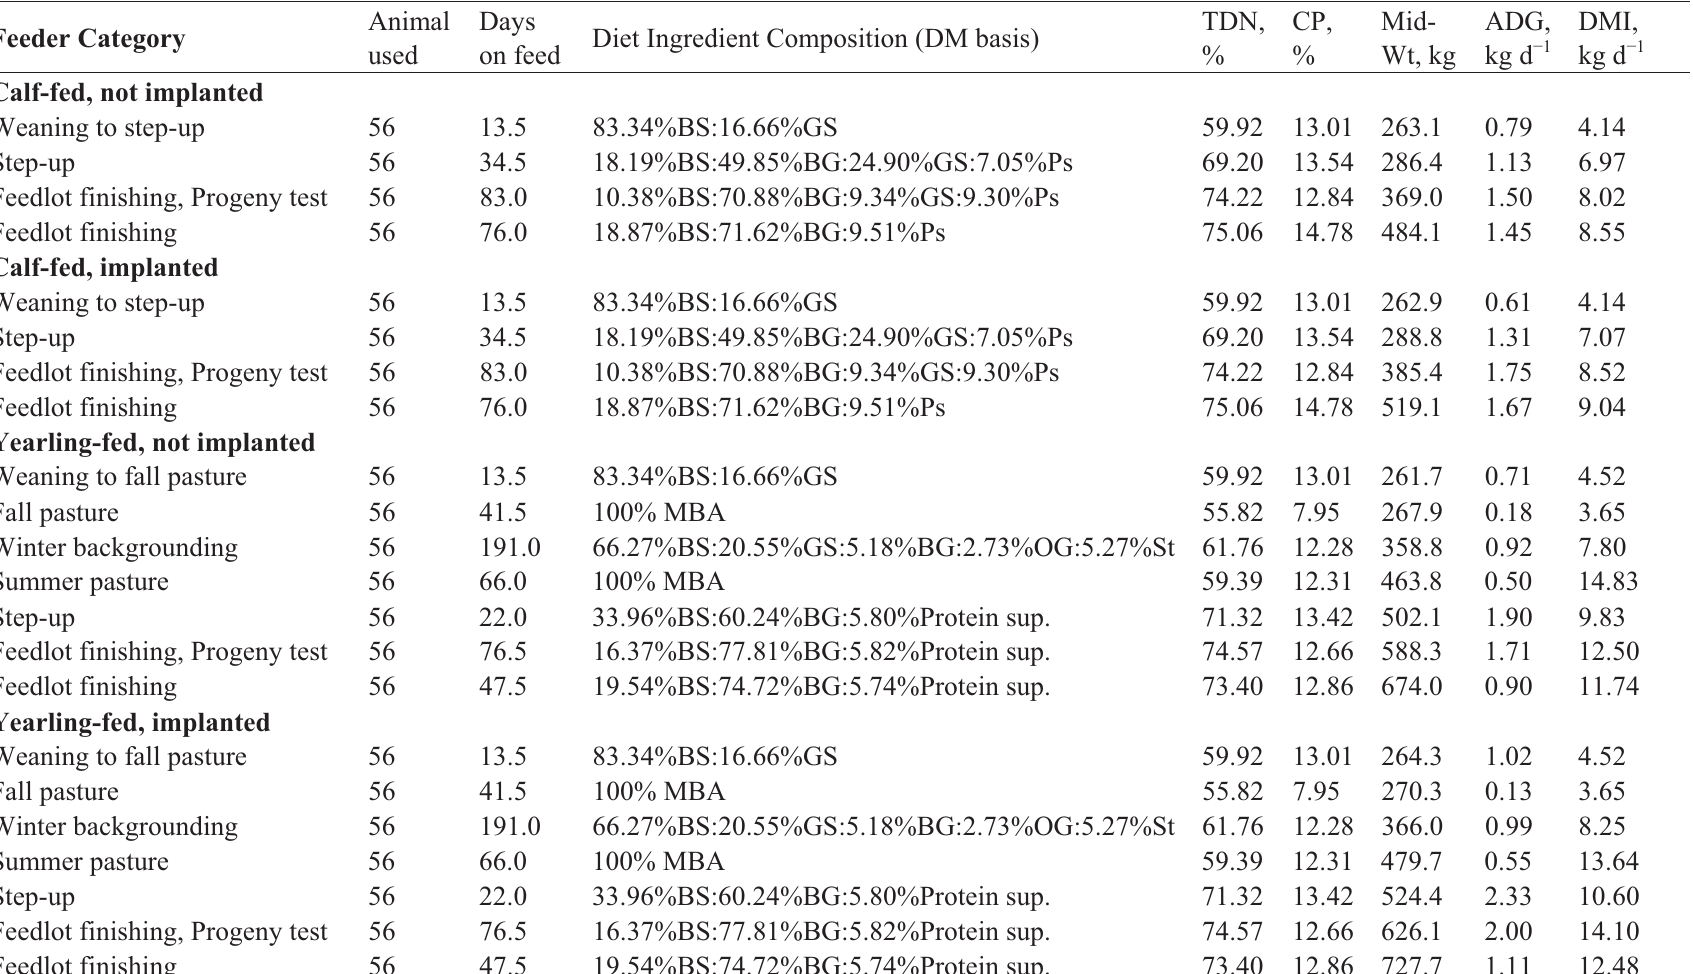
Table A2. Description of diets ingredient and nutrient composition, animal growth and feed intake by feeder category averaged over two years. Feeder